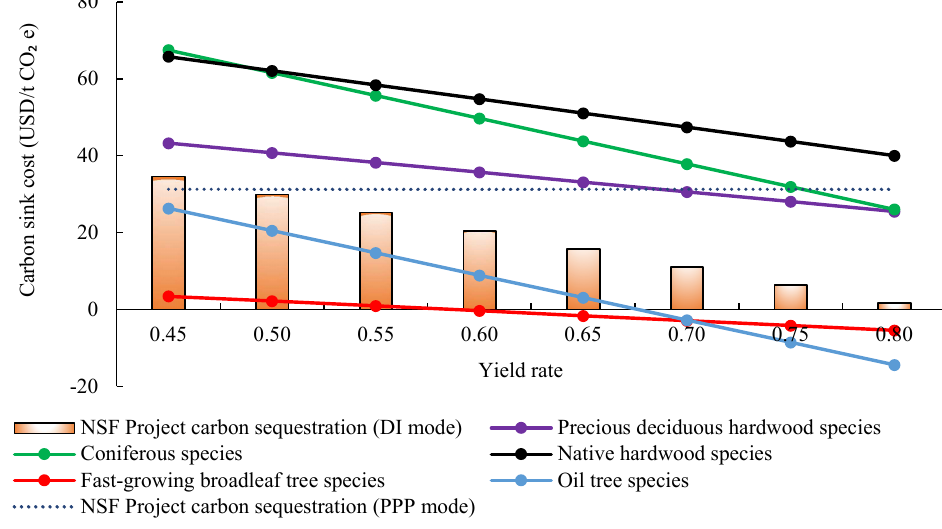
Figure 6. Carbon sink cost dynamic with yield rate in Laohekou NAP.